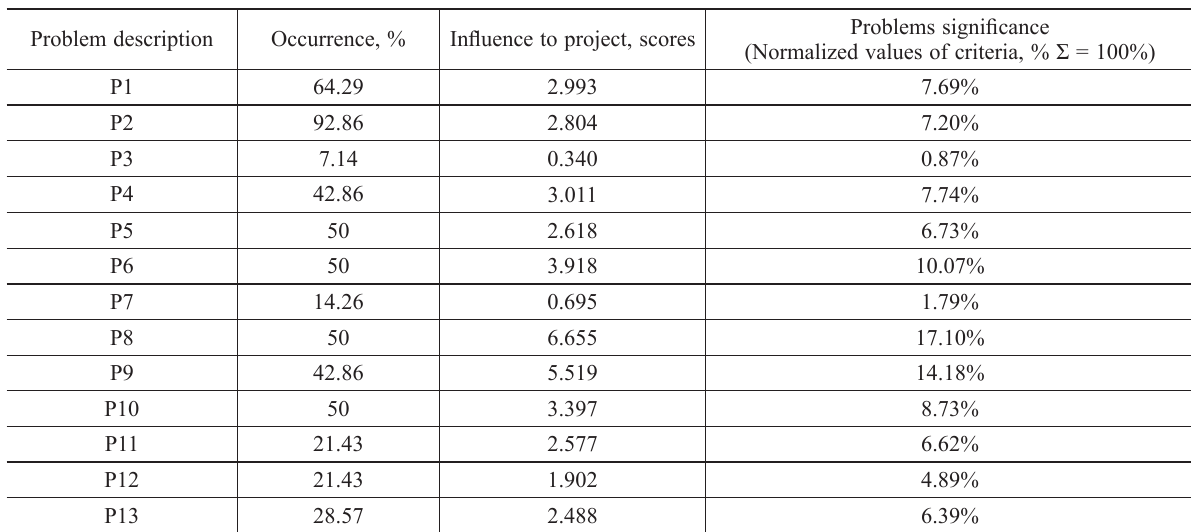
Table 4. Significance of the